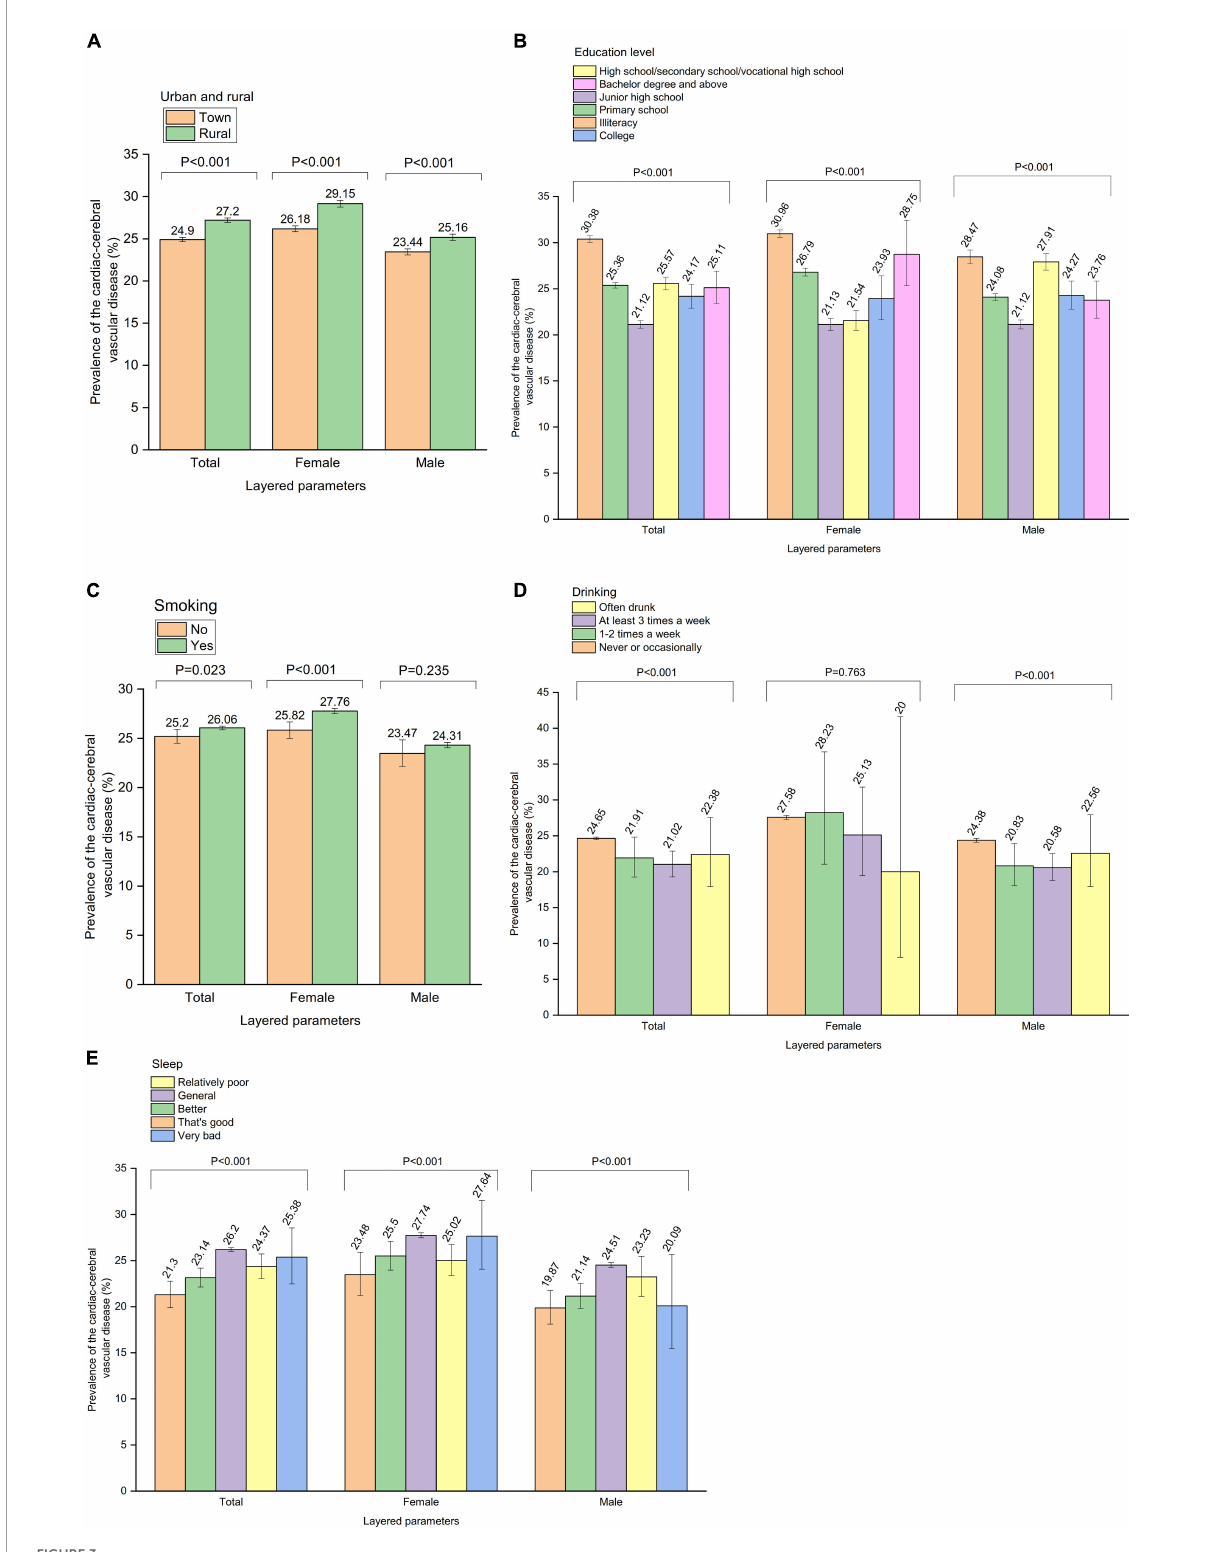
FIGURE3 The analysis of the relationship between parameters and cardiac-cerebral vascular disease was made further by gender stratification. Prevalence of the cardiac-cerebral vascular disease by (A) “Urban and rural” stratification, (B) “Education level” stratification, (C) “Smoking” stratification, (D) “Drinking” stratification, (E) “Sleep”